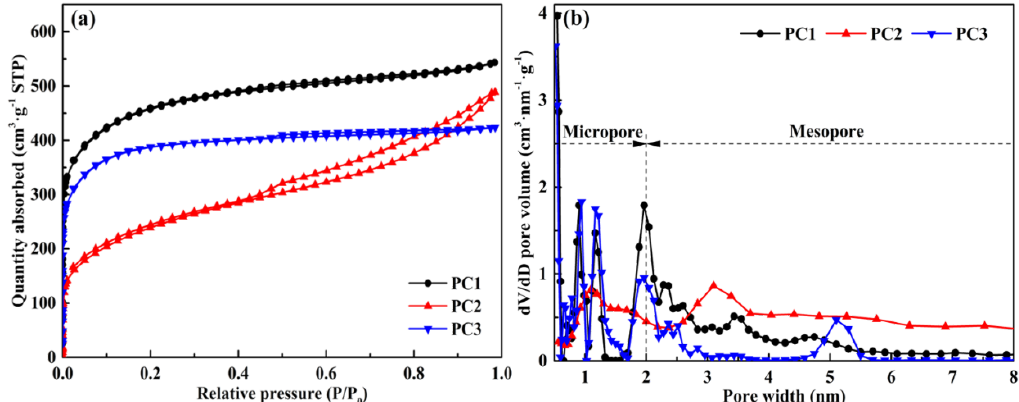
Figure 3. The pore structure of the porous carbons from waste palm (PC1, PC2, and PC3) of ( a ) N 2 adsorption-desorption isotherms; ( b ) pore size distribution by density functional theory (DFT) method. PC: porous carbon. Table 1. Structure parameters of carbon samples and their capacitive performance.